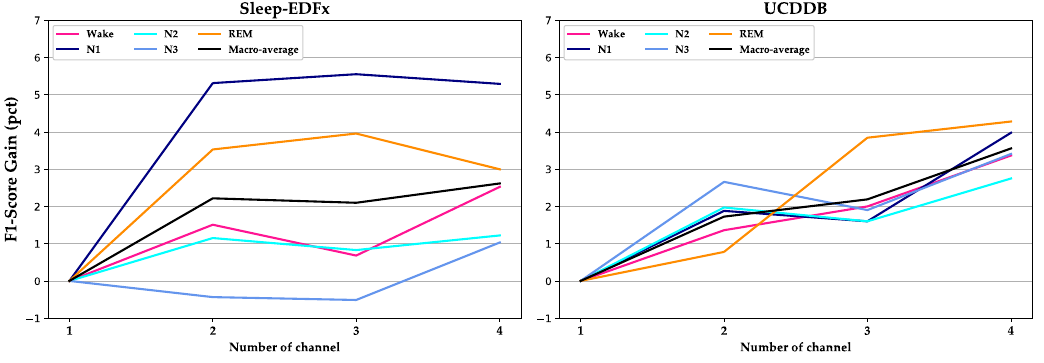
Figure 7. Performance gain for each stage by adding channels on Sleep-EDFx and UCDDB. The gain is computed by using the F1-score of each channel setting to subtract the F1-score of one channel.